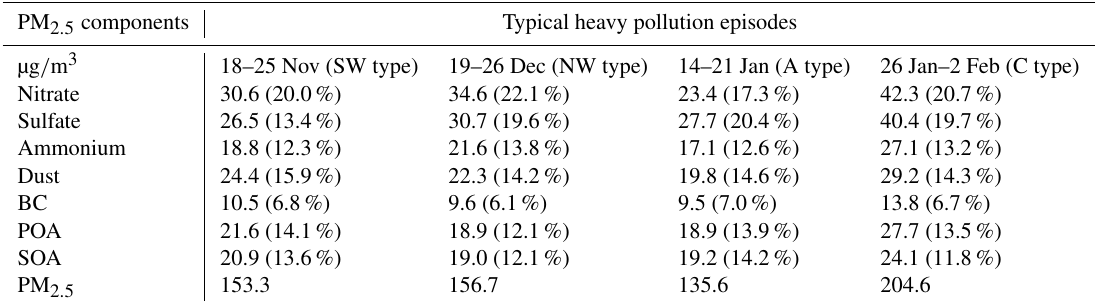
Table 3. Simulated PM 2 . 5 concentrations and associated chemical components averaged for the four typical heavy pollution episodes at Jingzhou. Also shown in brackets are the percentages of each component in PM 2 . 5 .